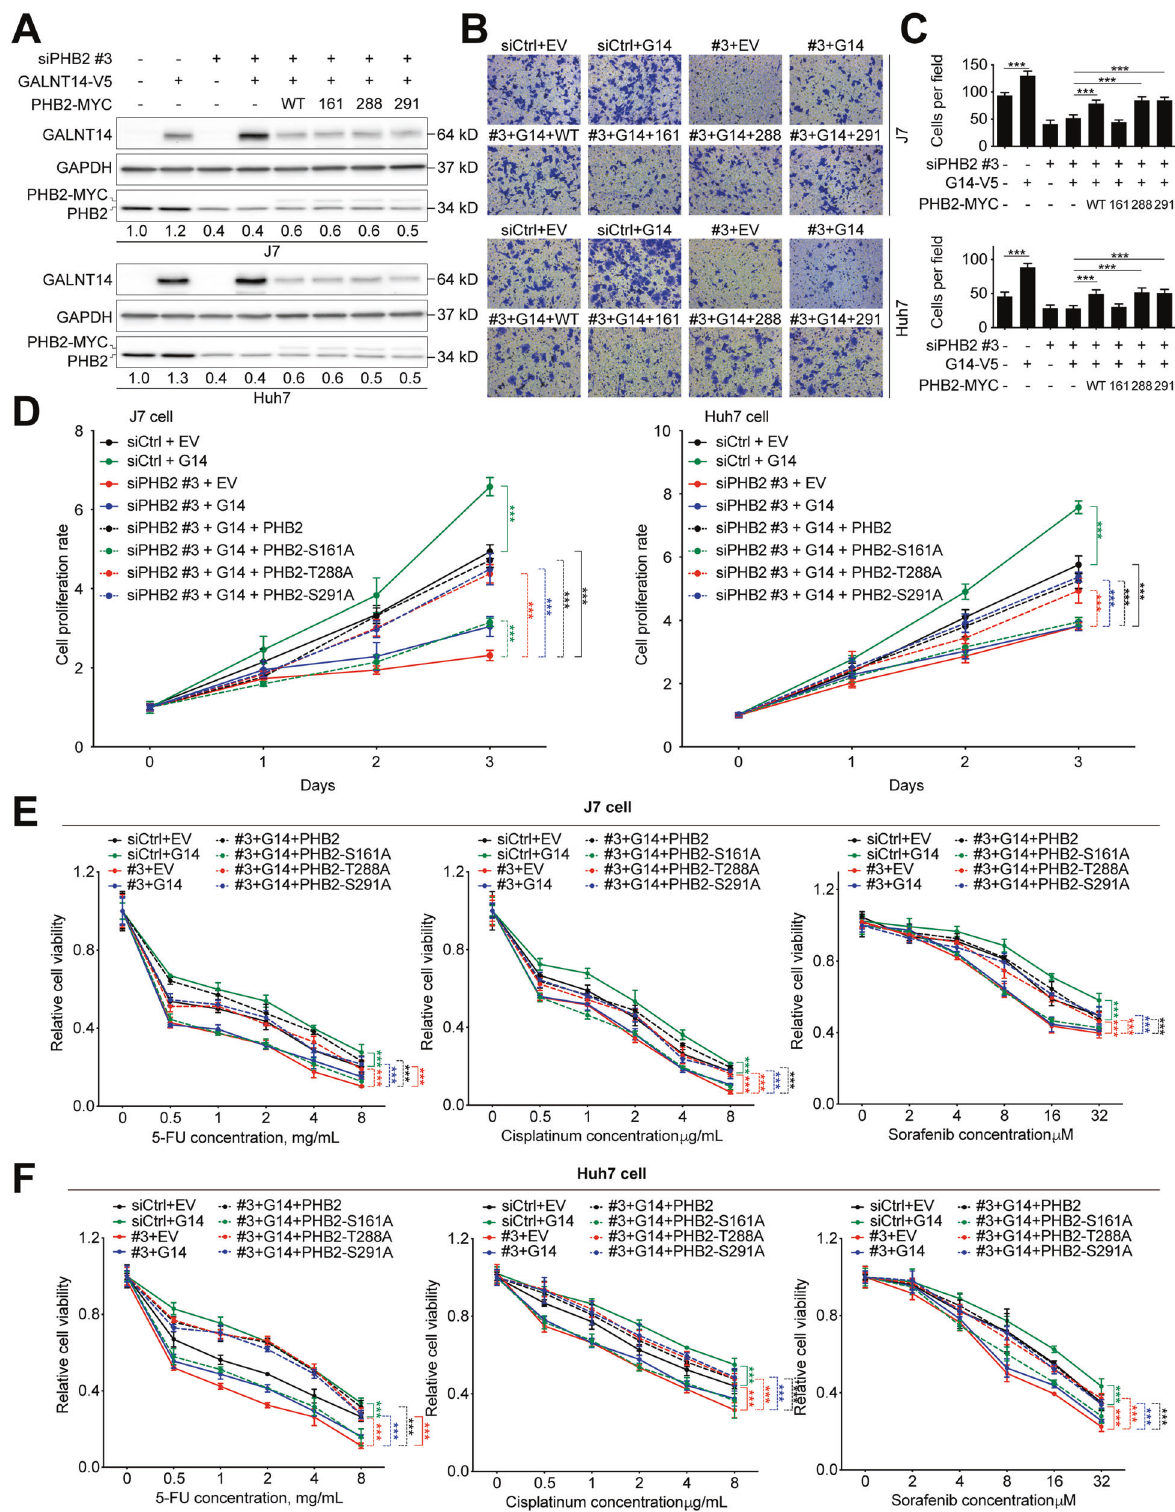
Fig. 5 O -glycosylation of PHB2 at Ser161 is crucial to orchestrate the GALNT14-induced phenotype. A Western blot analysis of lysates of cells transfected with the indicated plasmids. B Representative images of transwell-based migration assays. Quantitative results of migrated cells are shown in ( C ). P values were calculated by the two-tailed Mann – Whitney U test. D Alarmar blue-based cell growth assay using cells transfected with the indicated plasmids. P values were calculated by the two-way ANOVA. E , F Relative cell viability of anticancer drug-treated HCC cells transfected with the indicated plasmids. Three anticancer drugs were tested, including 5-FU, Cisplatin, and Sorafenib. P values were calculated by the two-way ANOVA. *** P < 0.001.